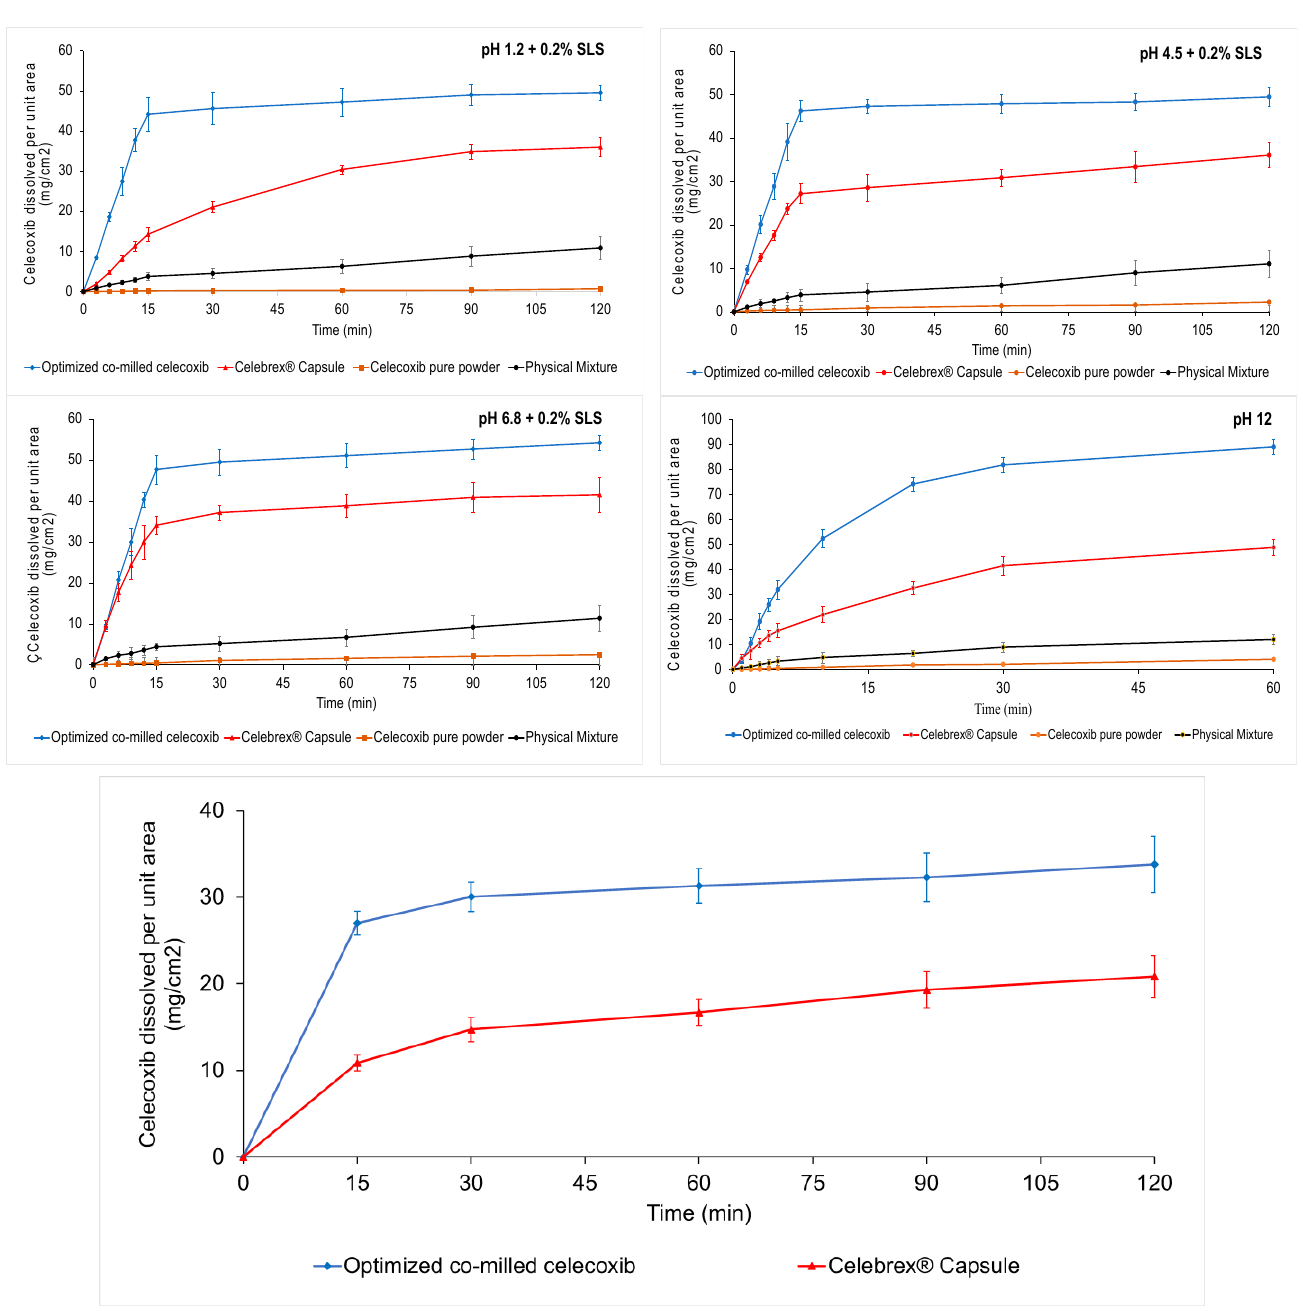
Figure 5. Intrinsic dissolution rate of CXB pure powder, PM, Celebrex ® capsule, and optimized co-milled CXB in different